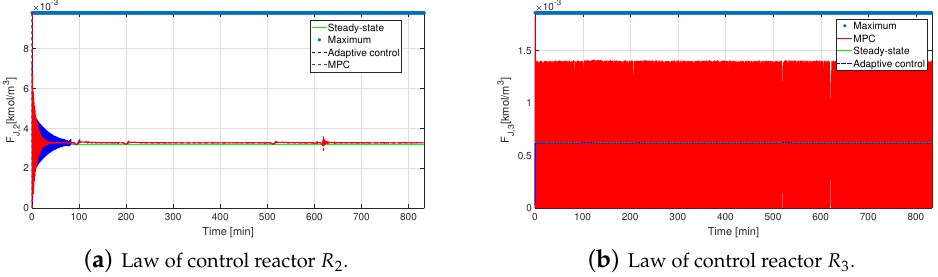
Figure 15. Performance of adaptive controller for simultaneous disturbances in F J ,1 and T R —concentration C A , i evolution.